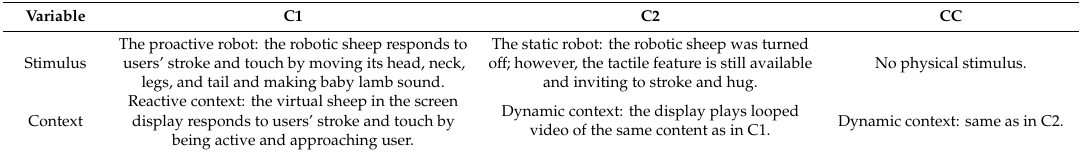
Table 1. Three experimental conditions with descriptive